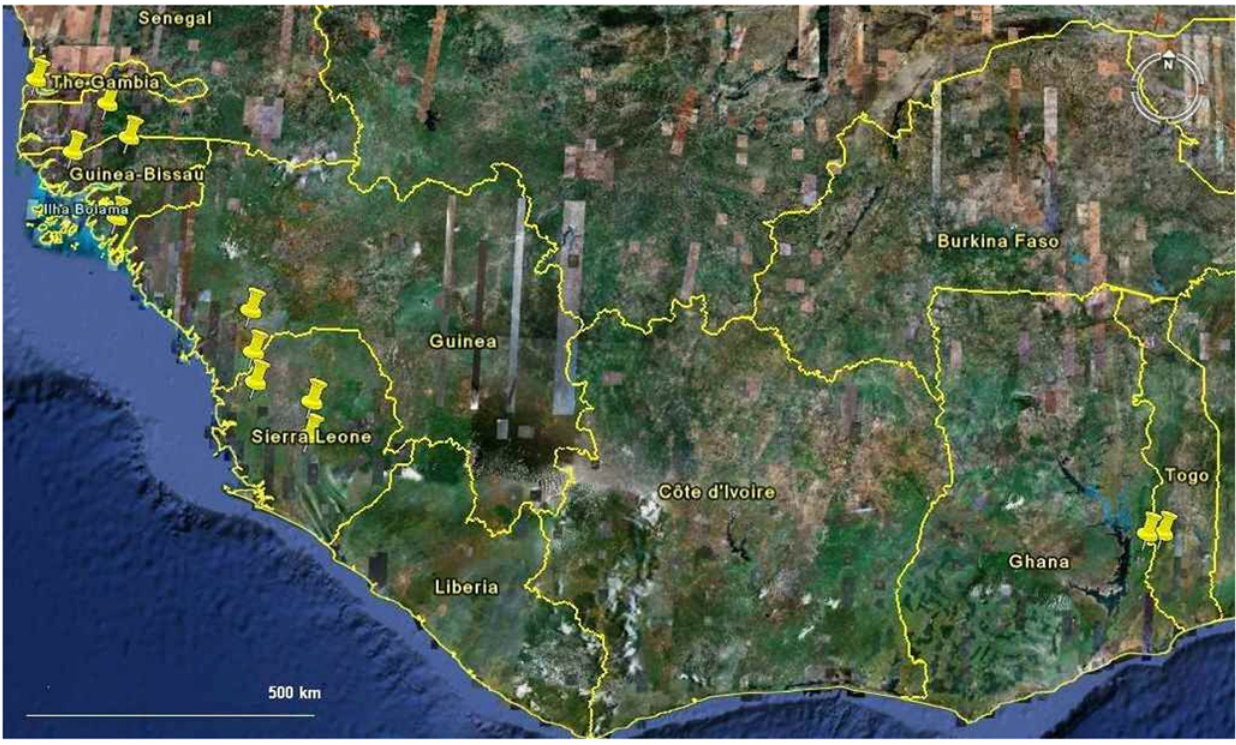
Figure 1. Geographic overview of the West African study area. Pushpins indicate study areas.